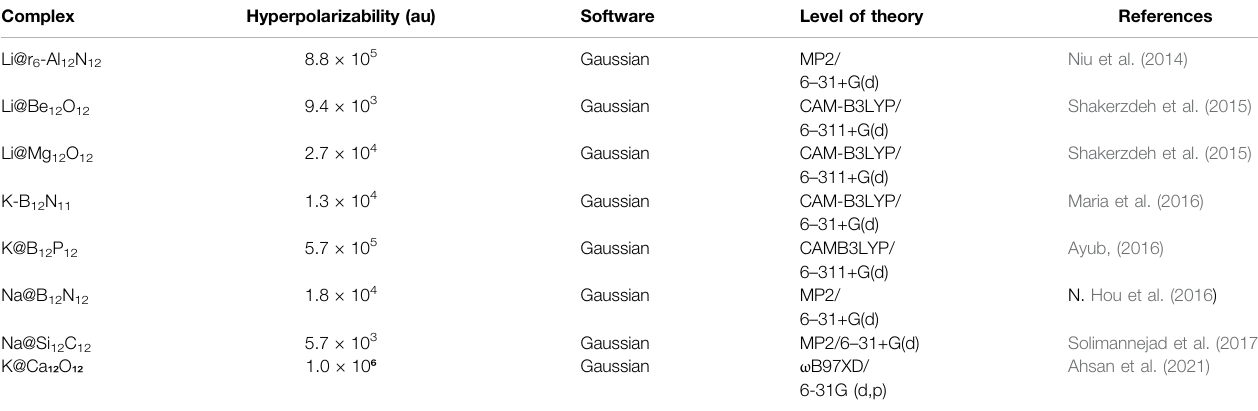
TABLE 3 | Alkali metal doped complexes with enhanced nonlinear optical